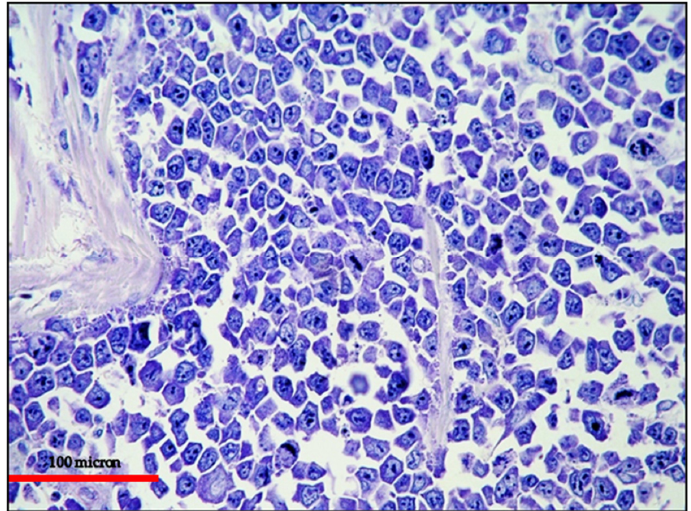
Figure 5. EC ‐ PEL of the ileum: high power highlighting the morphological details of large neo ‐ plastic cells with prominent nucleoli (Giemsa staining, magnification 400×; original image from Prof Ascani). PEL in its classic form usually fails to express pan-B-cell markers such as CD19, CD20, CD79 α and PAX5 as well as surface and cytoplasmic immunoglobulin. The classic form usually expresses